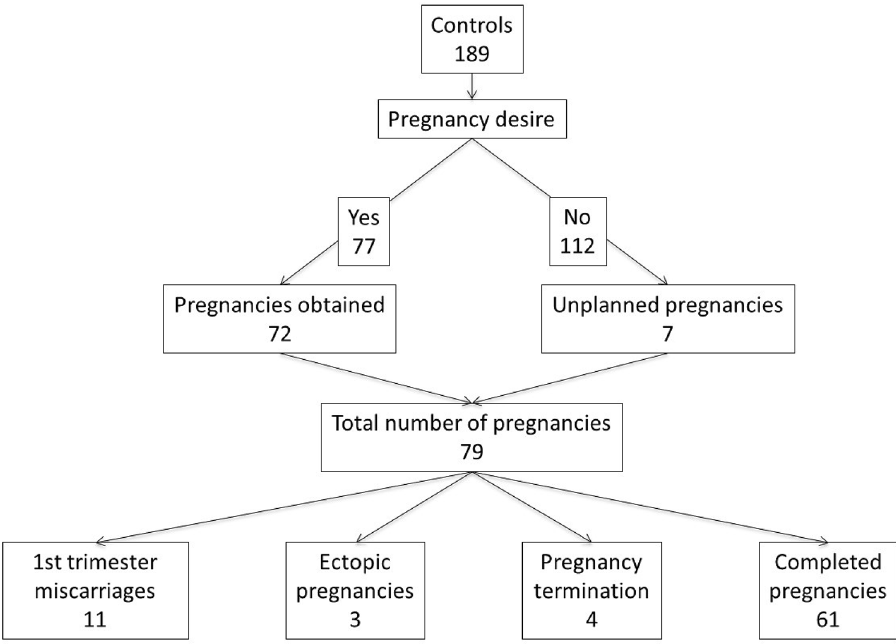
Figure 1. pregnancy desire and pregnancy outcomes, control